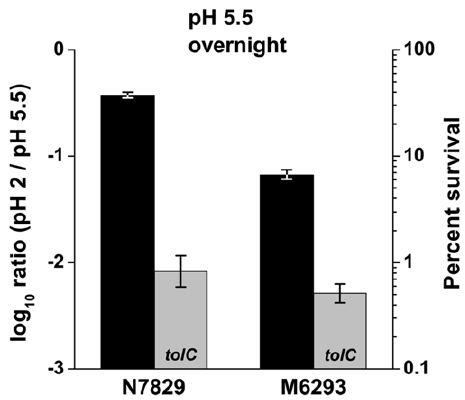
Figure 3. TolC is required for extreme-acid survival in a strain defective for eight MDR efflux inner membrane pumps. Strains N7829 (K-12 derivative), M5567 (N7829 tolC :: kan ), M6293 (N7829 acrB :: frt acrD :: frt emrB :: frt emrY :: frt macB :: frt mdtC :: frt mdtF :: frt acrEF :: spc ), and JLS1042 (M6293 tolC :: kan ) were grown overnight to stationary phase in LBK buffered at pH 5.5 (100 mM MES), diluted into LBK pH 2, and exposed for 2 hours at 37 u C. Grey bars represent the parent strain listed with the additional kanamycin resistance insertion in tolC . Error bars=SEM, n=6.